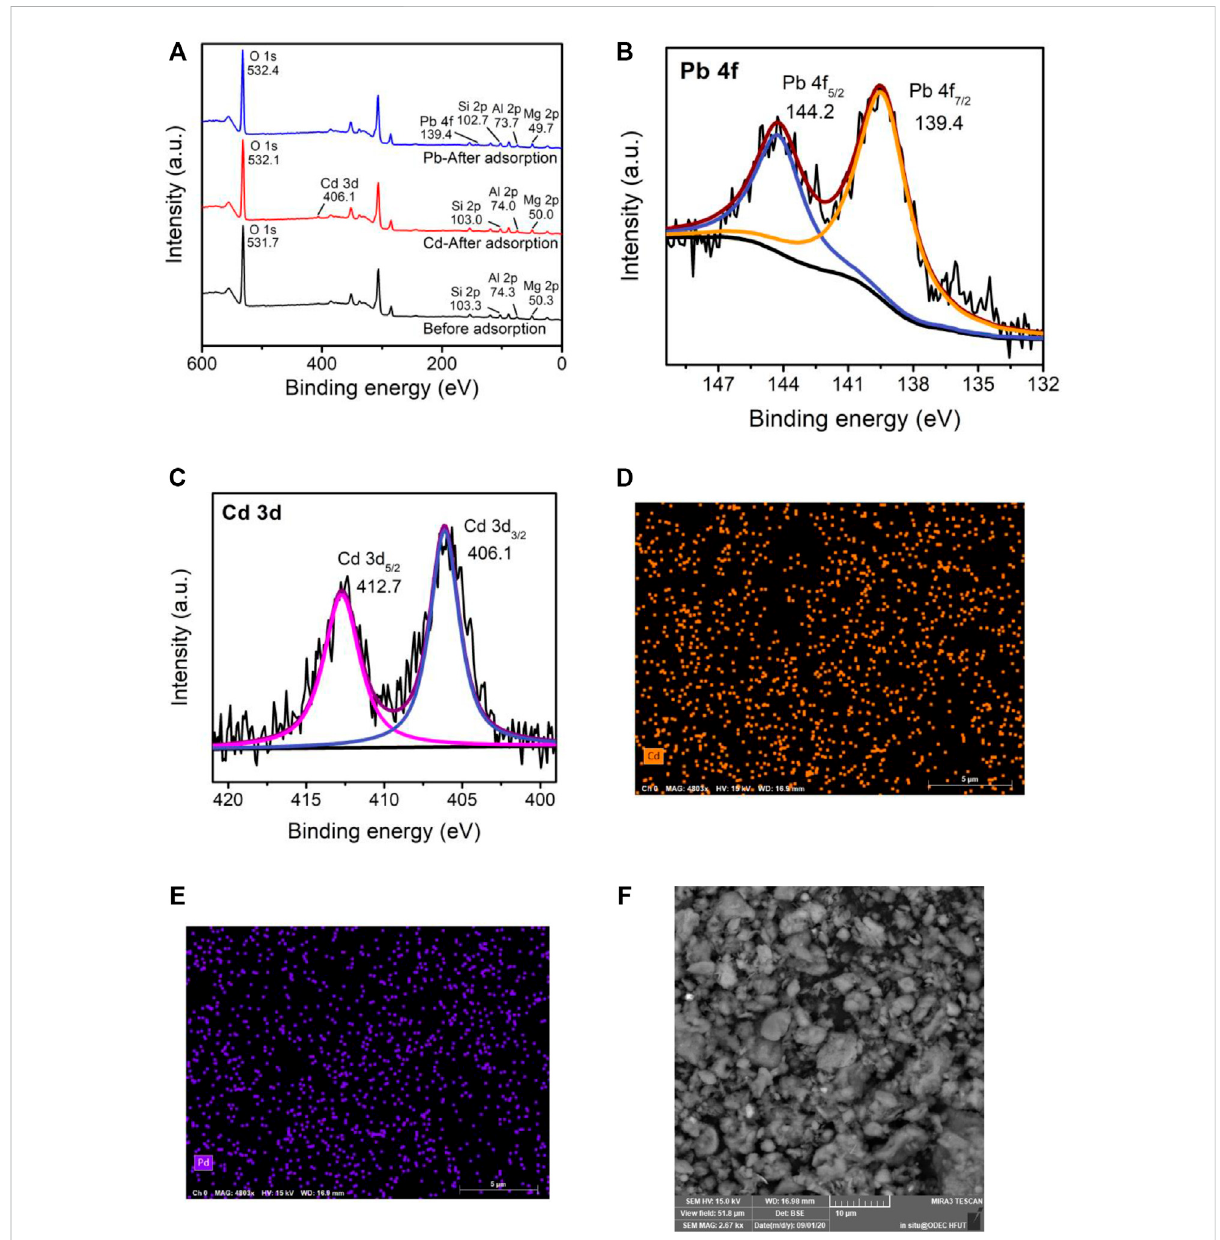
FIGURE 3 The XPS spectra (A – C) and SEM-ESD (D – F) of M-S-H before and after adsorption of Cd(II) and